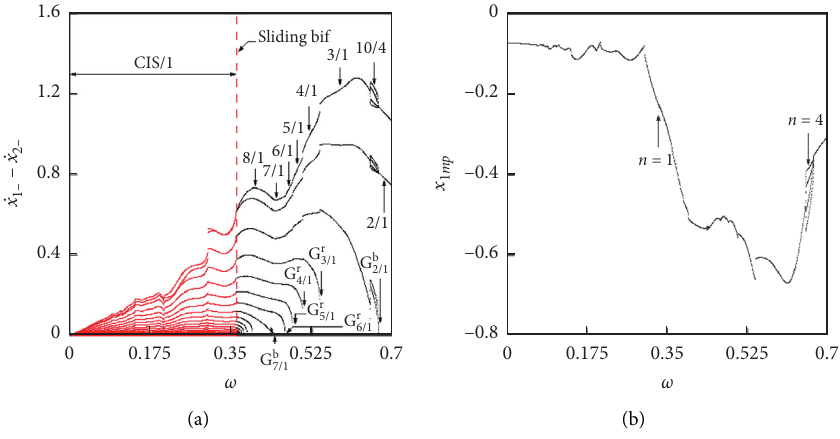
12 . (a) Impact bifurcation diagram; (b) periodic